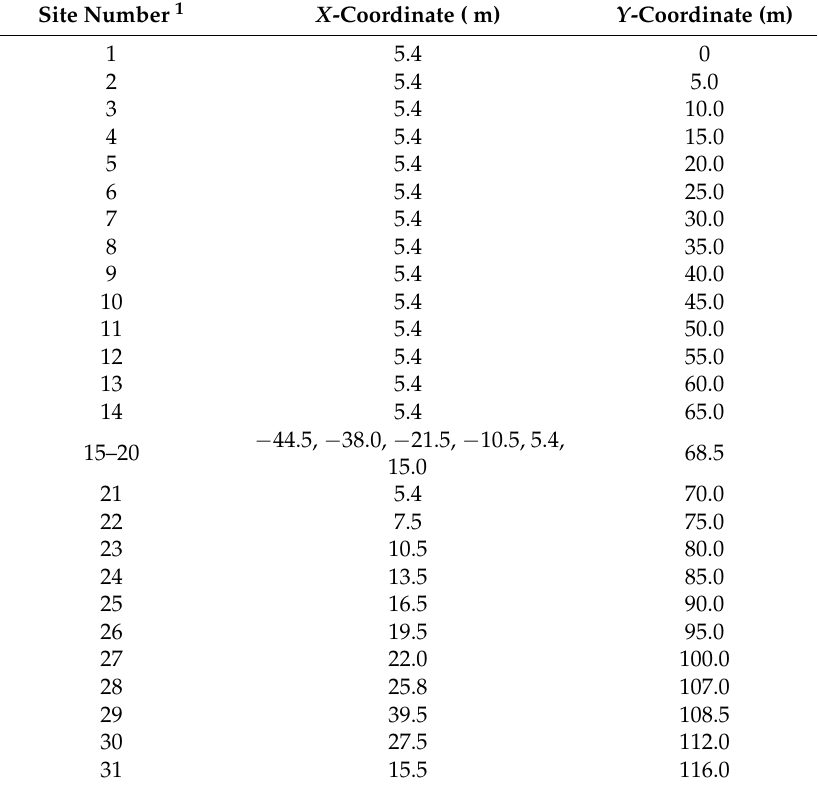
Table 1. PM 2.5 sampling